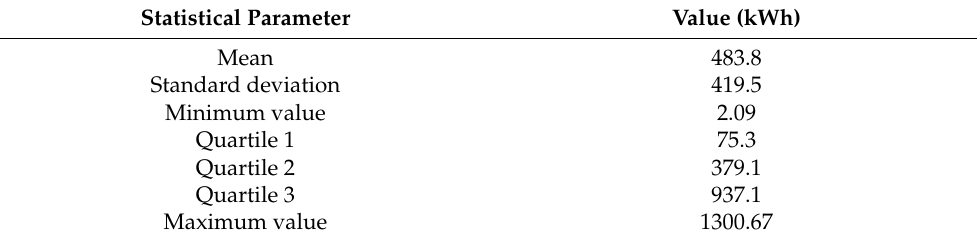
Table 2. Statistical parameters of daily energy-delivered